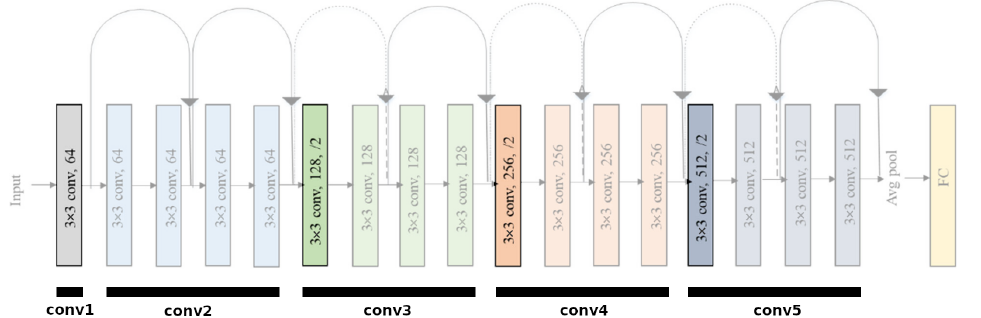
Figure 9. All 17 convolutional layers and one fully-connected layer of the unmodified ResNet18 network. The convolutional layers are grouped into 5 groups: conv1, conv2, conv3, conv4, and conv5. There are four convolutional layers that downsample the input tensor by using a stride of 2. They are the first convolutional layers in groups conv1, conv3, conv4, and conv5. These layers are emphasized in the image. There is also a max pooling layer between groups conv1 and conv2, which also downsamples the image by using a stride of 2. Since the input image is downsampled five times, the resulting tensor which is output by the final convolutional layer is 32 times smaller in both spatial dimensions than the input